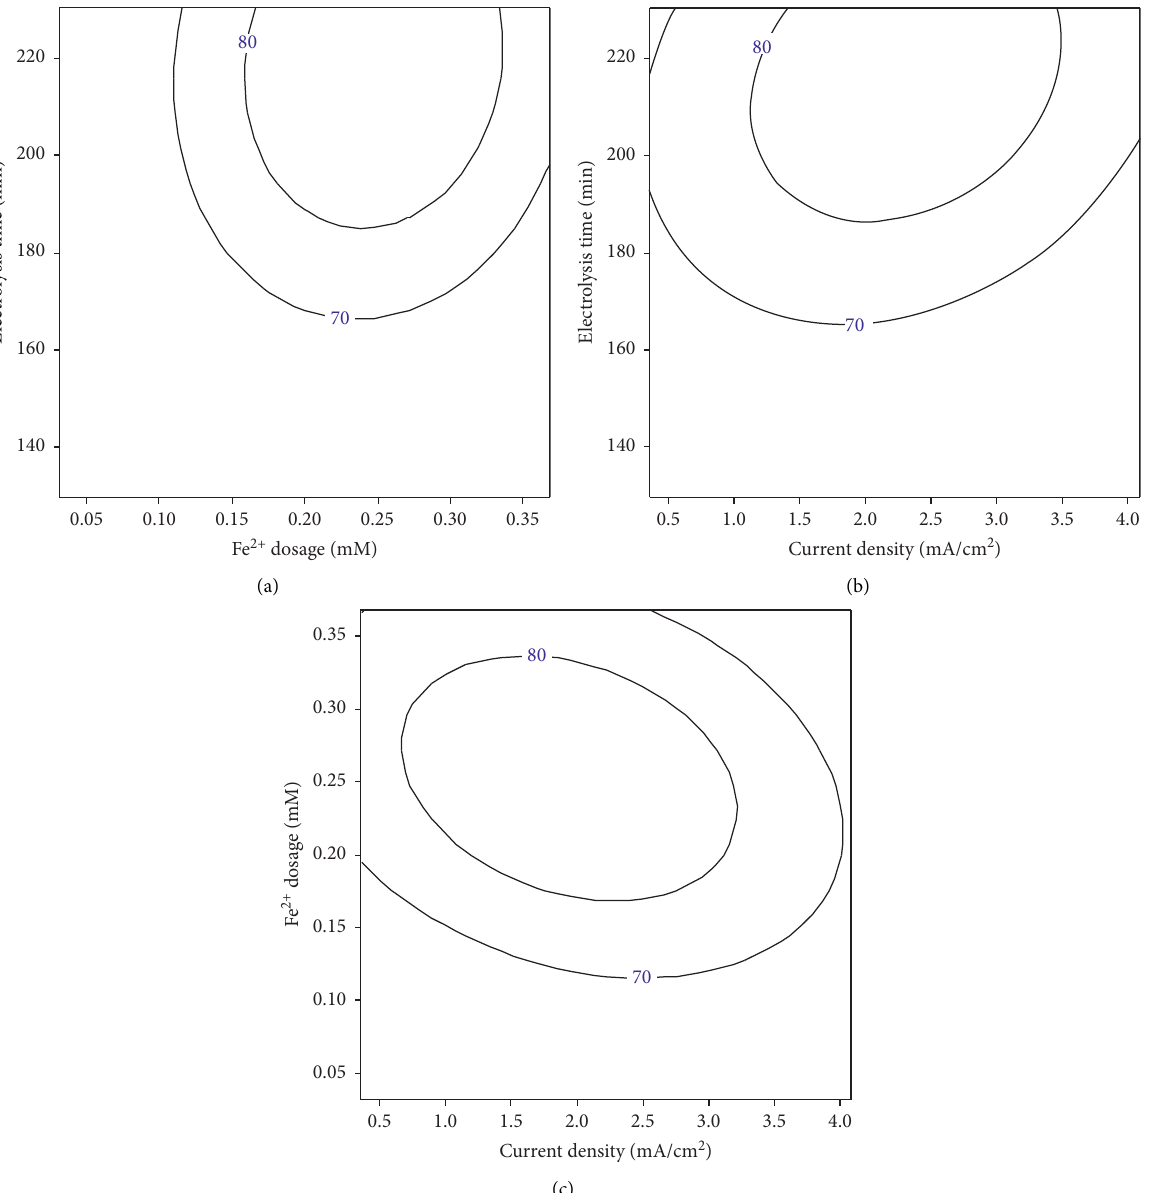
Figure 3: Respond contour plot of TOC removal at fixed condition: (a) current density of 2.5 mA/cm 2 , (b) Fe 2+ dosage of 0.2 mM, and (c) electrolysis time of 200